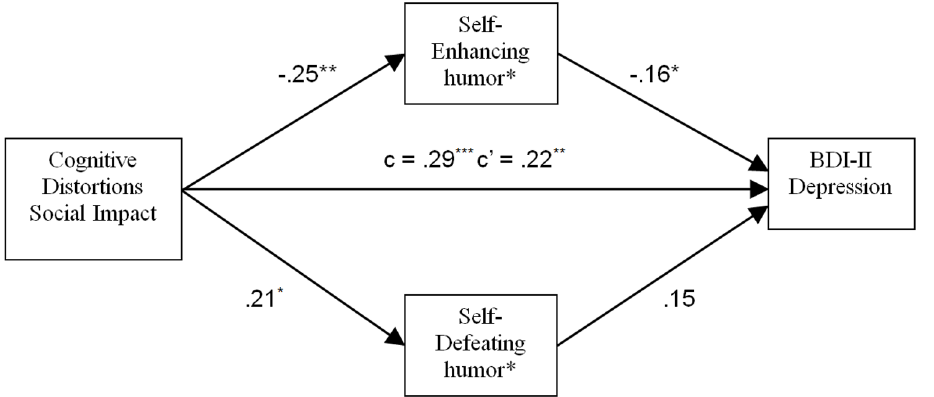
Figure 5. Mediating effect of Self-Enhancing and Self-Defeating humor on the relation between impact of cognitive distortions in social contexts and depressive symptoms. * p < .05. ** p < .01. *** p < .001.